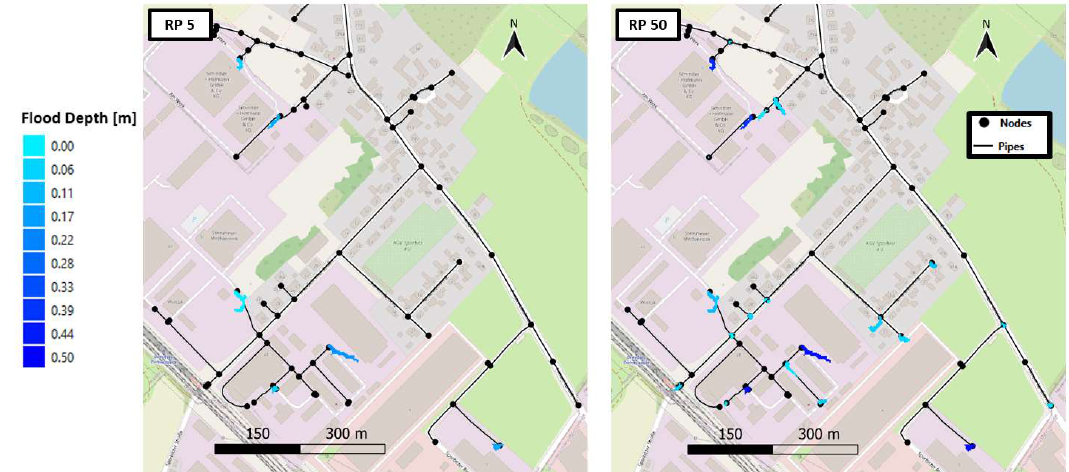
Figure 5. Examples of generated flood maps in the MS2 study area for a 5-year ( left ) and 50-year ( right ) return period synthetic rain events.